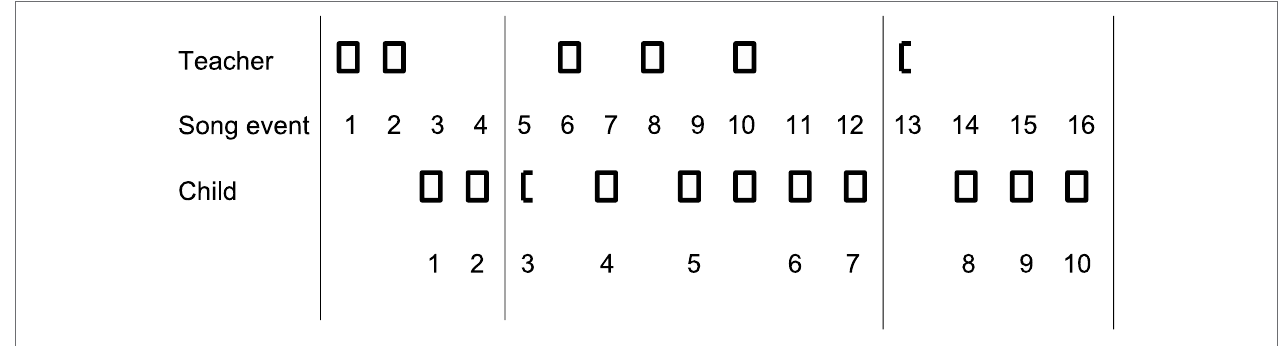
FIGURE 3 | Analysis of the interaction between teacher and child (Sabine) with respect to the target song. Squares represent the song sung by the teacher or by Sabine, and half squares represent incomplete reproductions of the first part. The vertical lines separate the sessions. The interaction analysis shows the typical pattern of transmission: The teacher presents the song, and the child gradually adopts